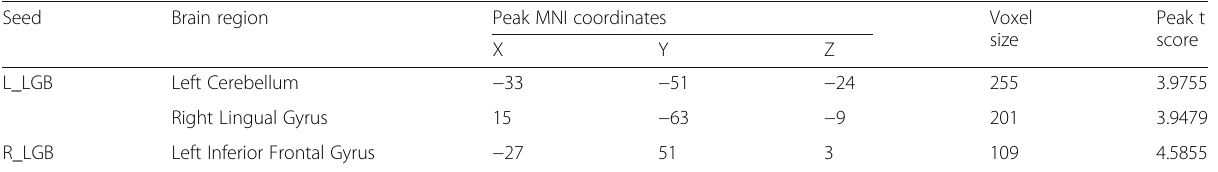
Table 2 The brain regions with Increased functional connectivity of bilateral lateral geniculate body in migrainerous without aura compared with controls